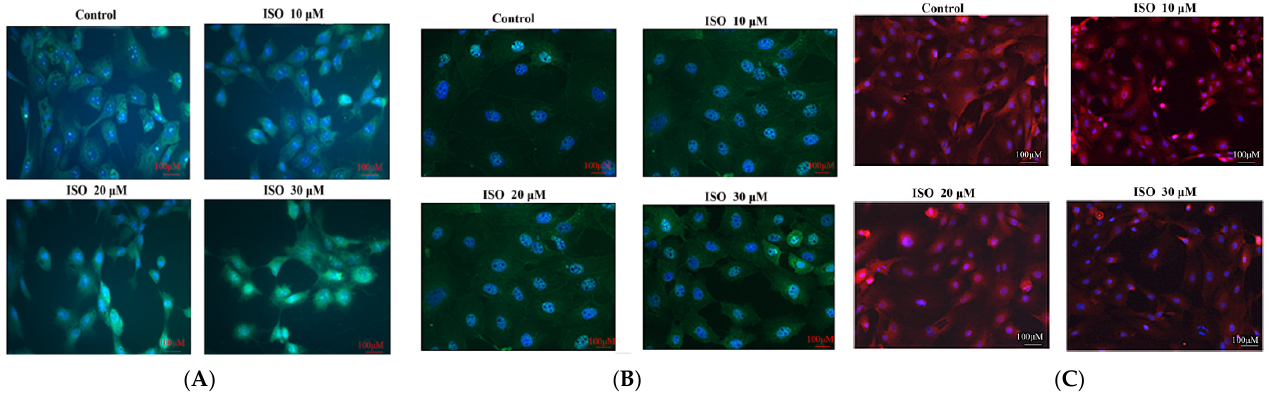
Figure 4. Effects of ISO on cyclins. Immunofluorescence analysis was positive for cyclins with dif- ferent ISO concentration supplementations. ( A ) Cyclin D1 protein; ( B ) cyclin E protein; ( C ) p21 protein.